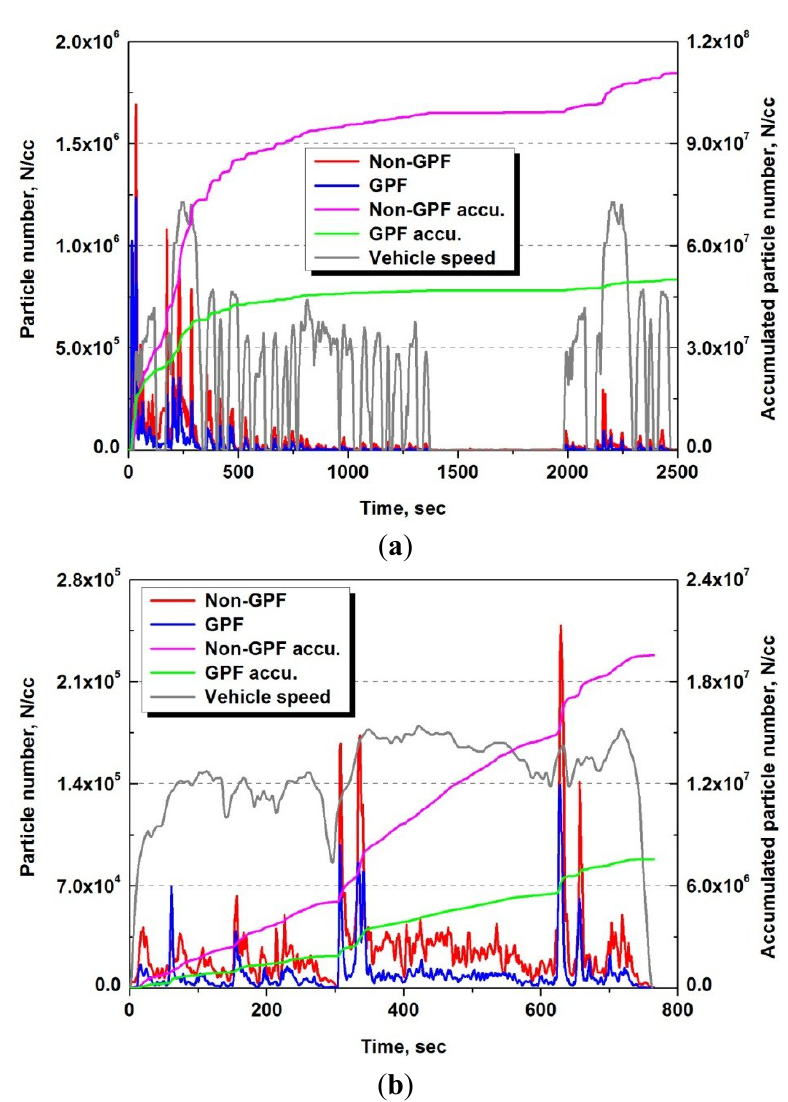
Figure 6. Real-time particle number concentration by CPC of FTP-75 and HWFET mode; ( a ) FTP-75 mode; ( b ) HWFET